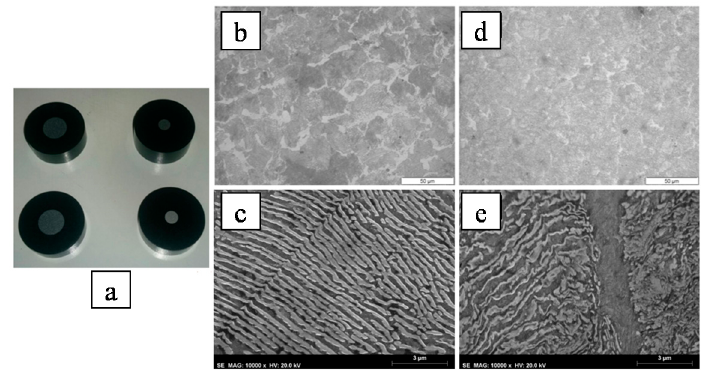
Figure 21. ( a ) Prepared samples for microstructural analysis; (b ) Optical zoom at the web (500×); ( c ) SEM at the web (10,000×); ( d ) Optical zoom at the rim (500×); ( e ) SEM at the web (10,000×).